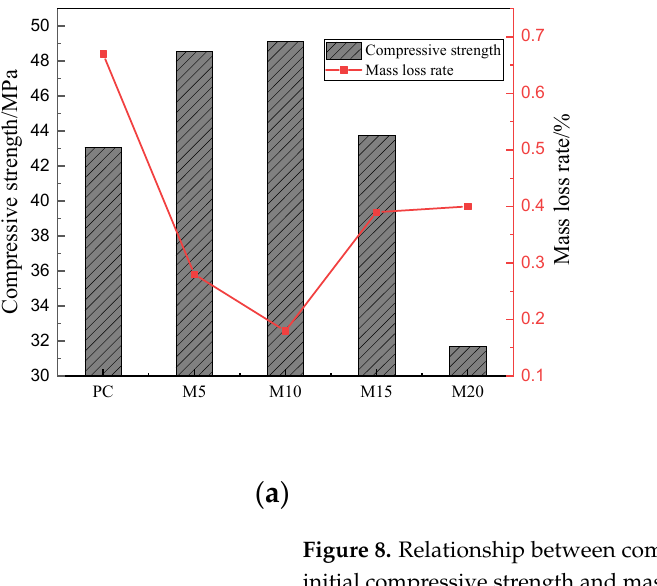
( b ) Figure 7. Mass loss rate of PC and M10 after a different erosion period under different curing con- ditions; ( a ) PC, ( b ) M10. In order to more clearly see the relationship between the compressive strength and sulfate resistance of the sample, Figure 8 was drawn. As we have explained in the previ- ous discussion, for metakaolin cement mortar, the 3# curing method is the best curing method, so Figure 8 shows the relationship between the compressive strength and the mass loss rate under the 3# curing method. Figure 8a shows the relationship between the